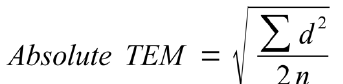
Table 2. The mean values , standard deviation, minimum and maximum values, and the correlation to body fat percentage obtained by DXA (r%BF ) and DXA